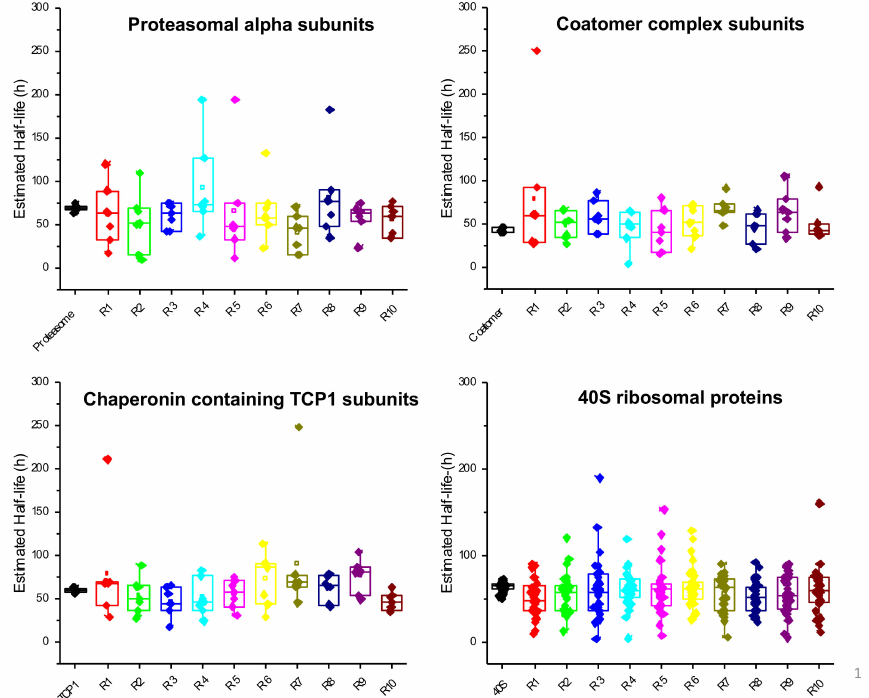
Figure 9. Box plots showing the distribution of half-lives for proteins belonging to the macromolecular complexes indicated in Figure 8, compared to the distribution of half-lives relative to 10 randomly selected populations of proteins generated automatically from the same